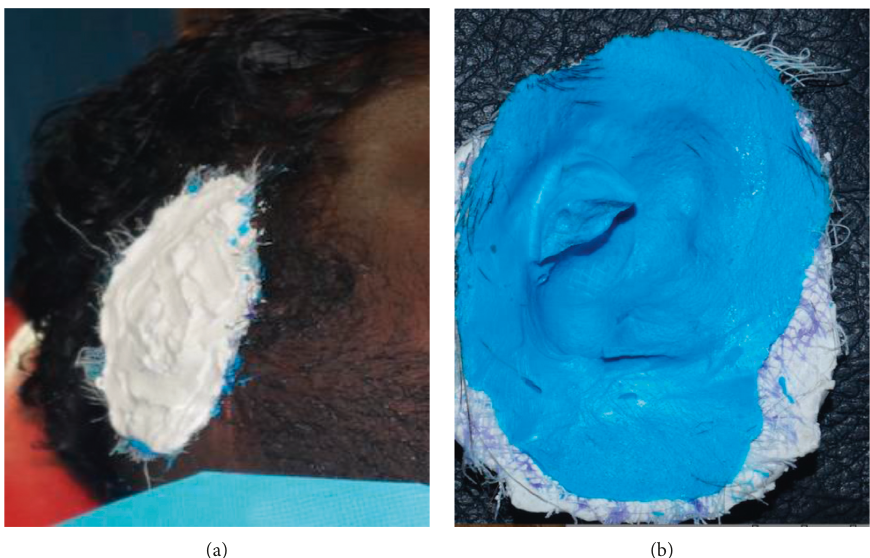
Figure 3: Impression of missing ear using polyvinylsiloxane.